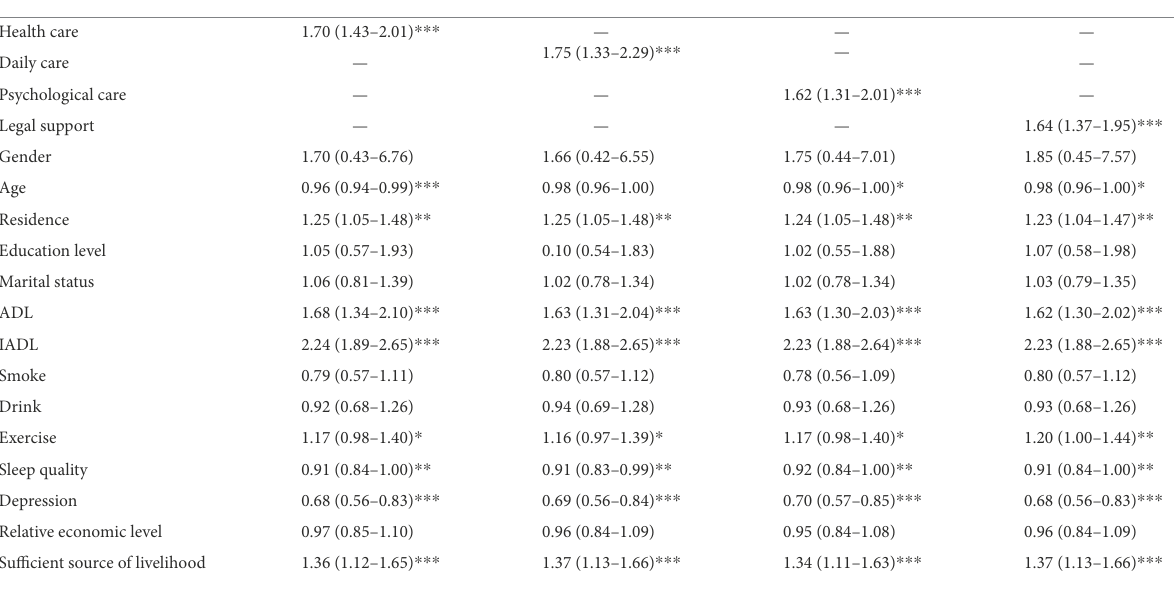
TABLE 3 Panel estimation results of the impact of classified community support on the cognitive function of the elderly, OR (95% CI). Variables